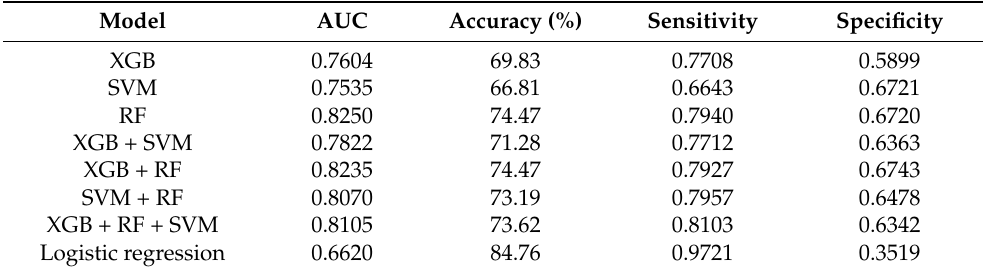
Table 4. Values of machine learning and logistic regression analysis using the classification of the combination of the normal, possible, and probable groups versus the confirmed group.